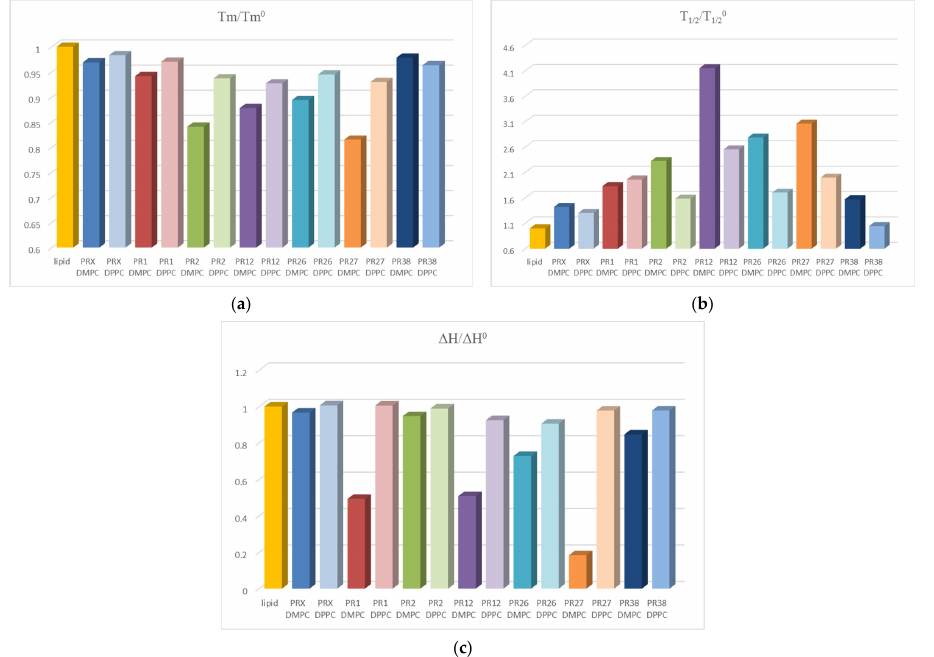
Figure 5. Relative parameters of phospholipid main phase transition: main transition temperature Tm ( a ), transition peak width at half ‐ height T 1/2 ( b ), transition enthalpy ∆ H ( c ) for DPPC and DMPC in the presence of studied compounds at compound:phospholipid molar ratio 1:10.